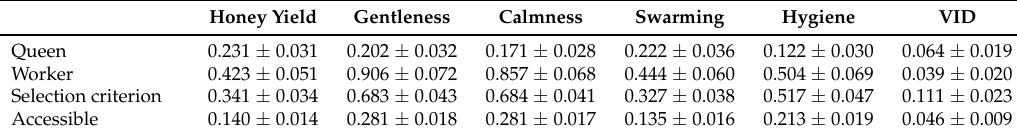
Table 3. Heritabilities and their standard errors of models used in breeding value estimation. Honey Yield Gentleness Calmness Swarming Hygiene VID